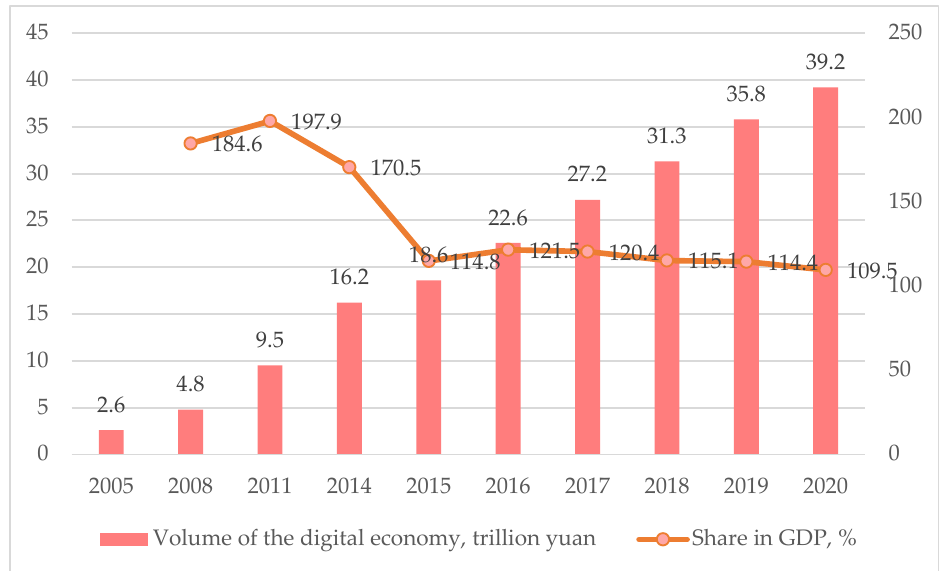
Figure 3. Dynamics of China’s digital economy and the digital economy’s share in GDP (latest period to previous period), 2005–2020